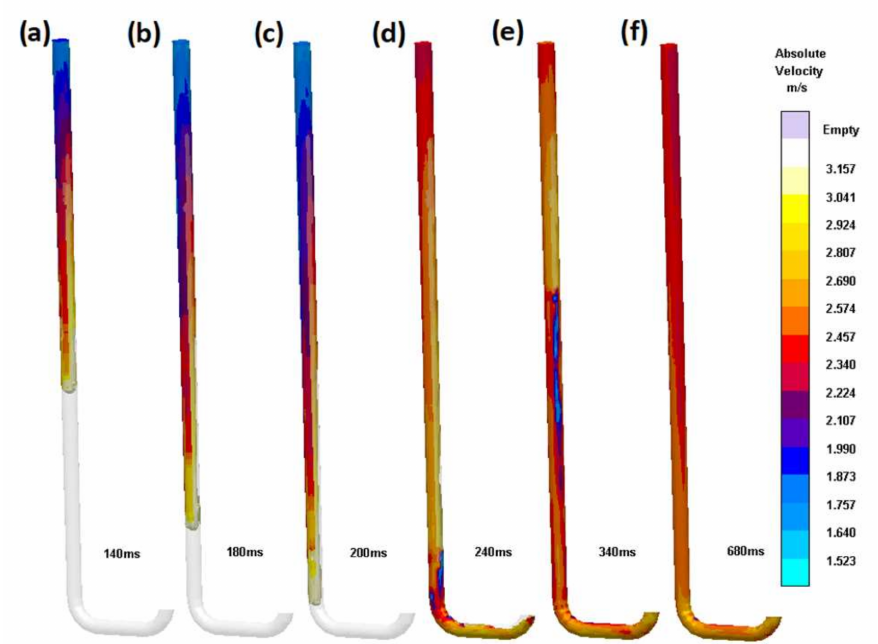
Figure 11. Round sprue with hyperbolic taper (S i 3). Subsequent stages of the flow ( a ) 140